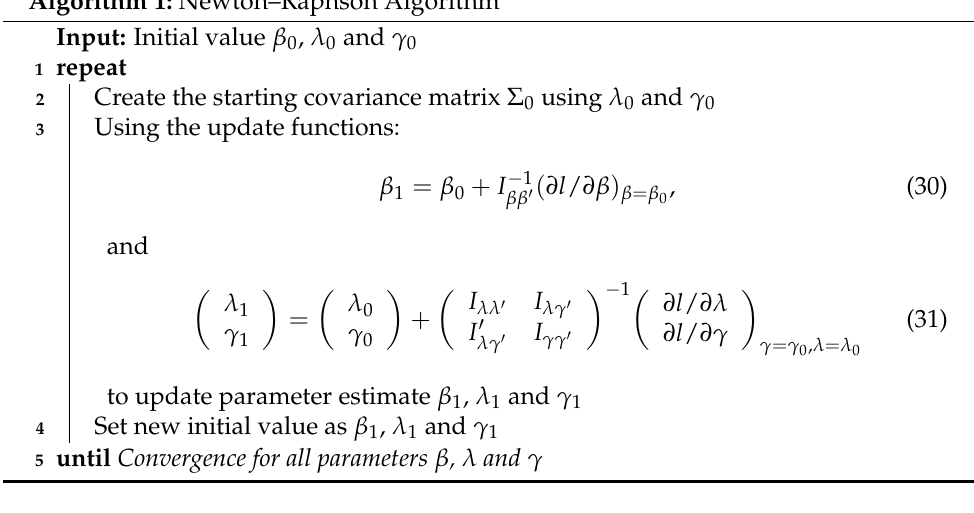
Algorithm 1: Newton–Raphson Algorithm